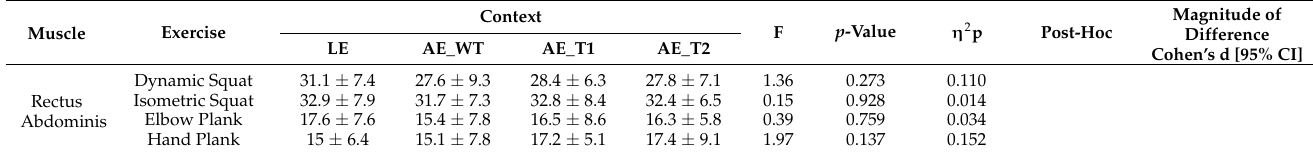
Table 5. Descriptive analysis (mean ± standard deviation) of EMG magnitude (%) and inferential analysis of the activation of the rectus abdominis muscle as a function of the exercises and taking into account the context